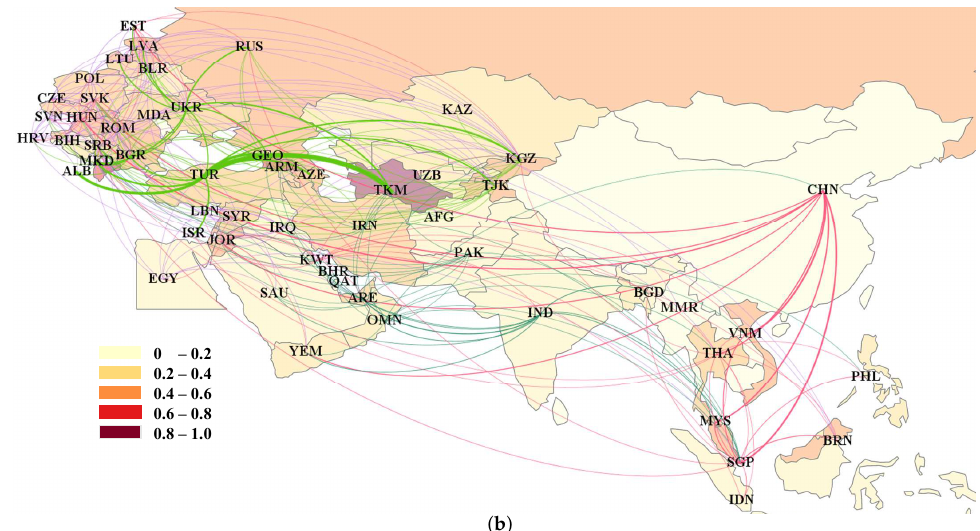
Figure 9. Top EGSR network. The color shades imply the values of EGSR normalized by the total EGSR s. The edges of the same color are members of the same cluster. The clockwise bending direction of the edge represents the direction of EGSR transfer. ( a ) Top 4 EGSR import network; ( b ) Top 9 EGSR import